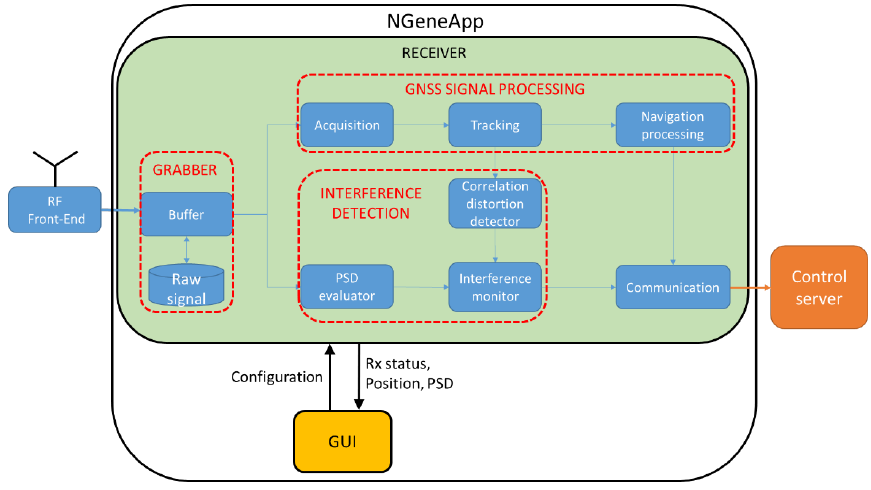
Figure 1. NGeneApp high-level architecture.